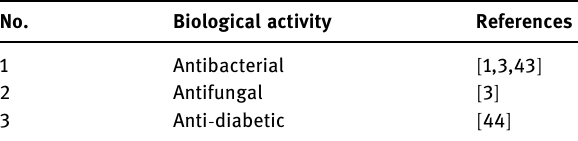
Table 3: Biological activities exhibited by nanopropolis